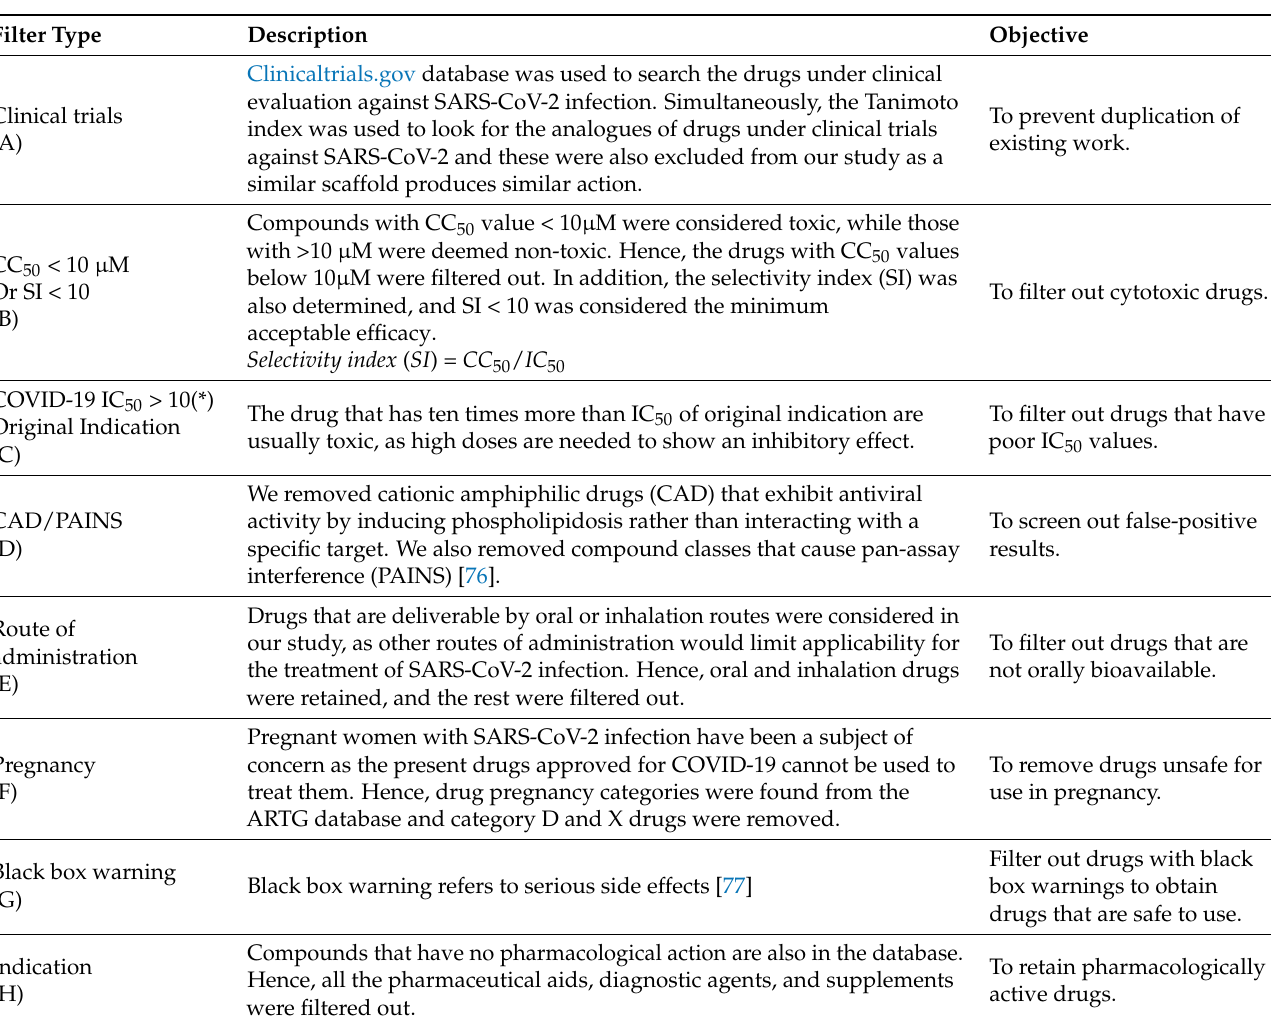
Table 5. Sub-filters used for the